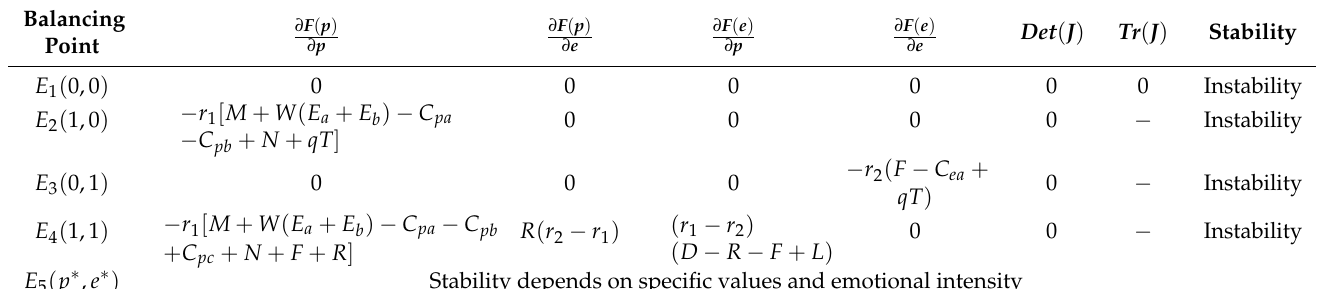
Table 6. Stability analysis of the strategy combination under shared manufacturing supply chain emotion, shared platform emotion